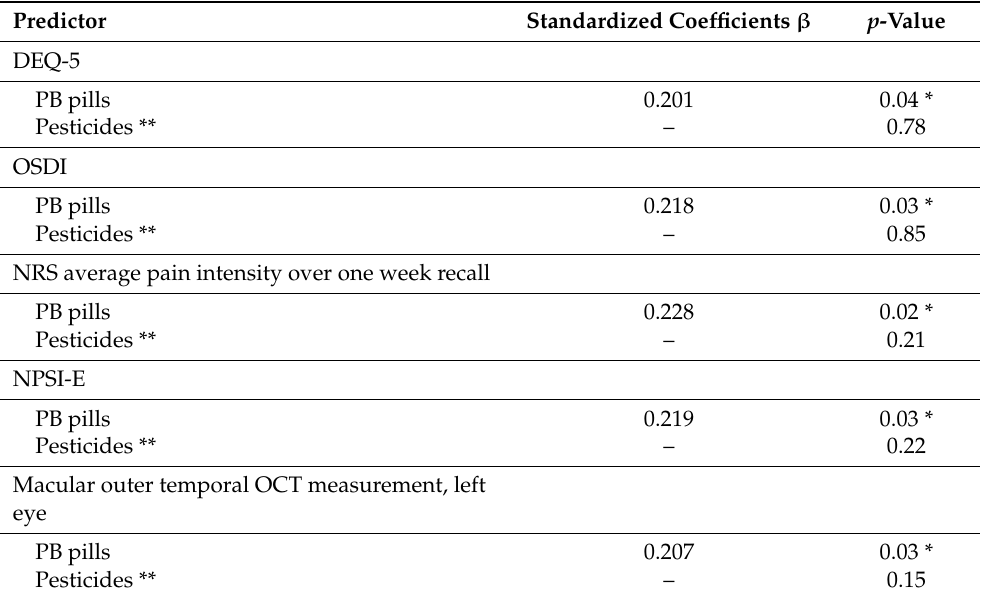
Table 3. Linear regression for predictors of significant ocular